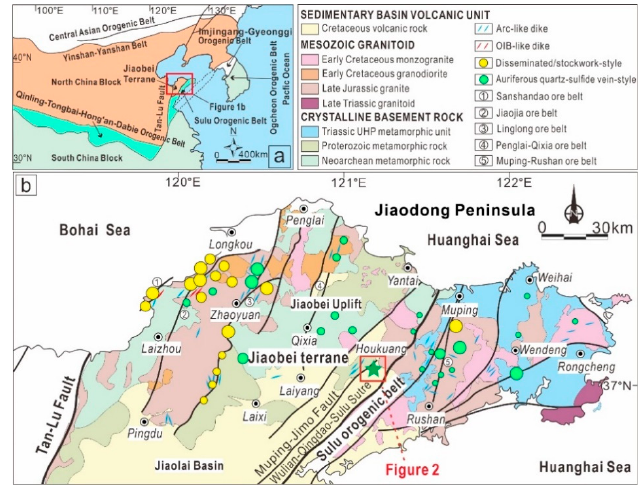
Figure 1. Simplified map showing the location of the Jiaobei Terrane ( a ) and geological map of the Jiaodong Peninsula ( b ) . The dashed line means the eastern continuation of the Dabie–Sulu orogenic belt and the rectangle shows the Muniushan monzogranite [35] .